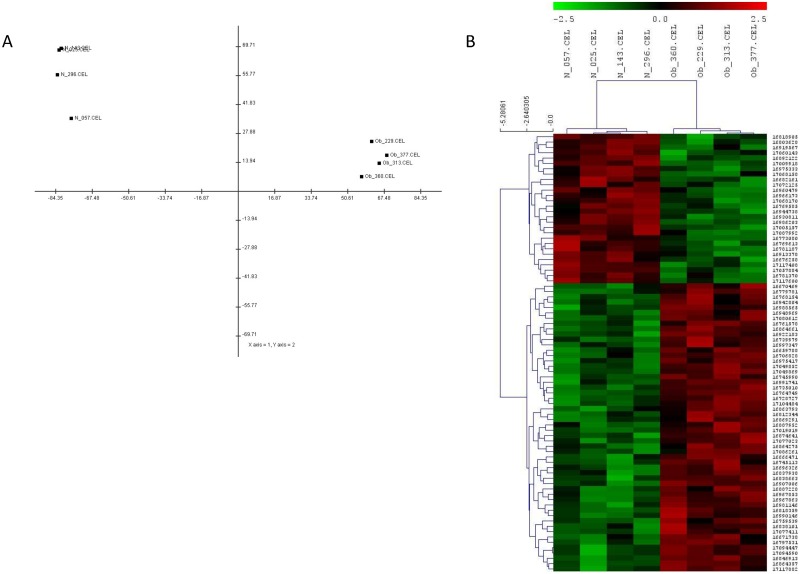
(A) Principal component analysis (PCA) of term placental gene expression profiles in obese (Ob_ N°) and normal weight women (N_N°). (B) Cluster analysis of dysregulated genes in term placentas from obese (Ob_ N°) vs. normal weight women (N_N°). Red represents genes with high expression levels and green represents genes with low expression levels.